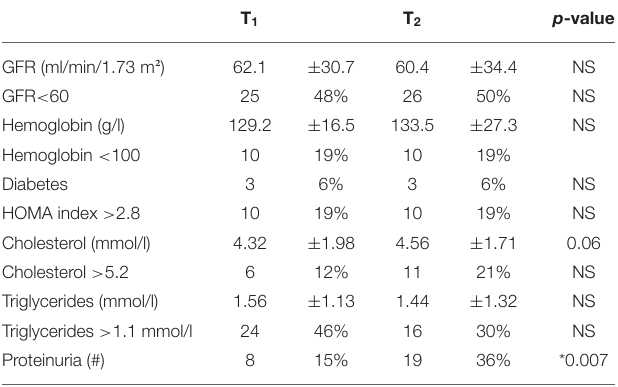
TABLE 2 | Laboratory data at T 1 and T 2